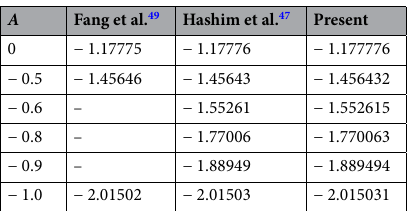
Table 1. Comparison of results in limiting case with Fang et al. 49 and Hashim et al. 47 , when 1 ) 0 for f β ∗ s M We ′′ ( = = = =